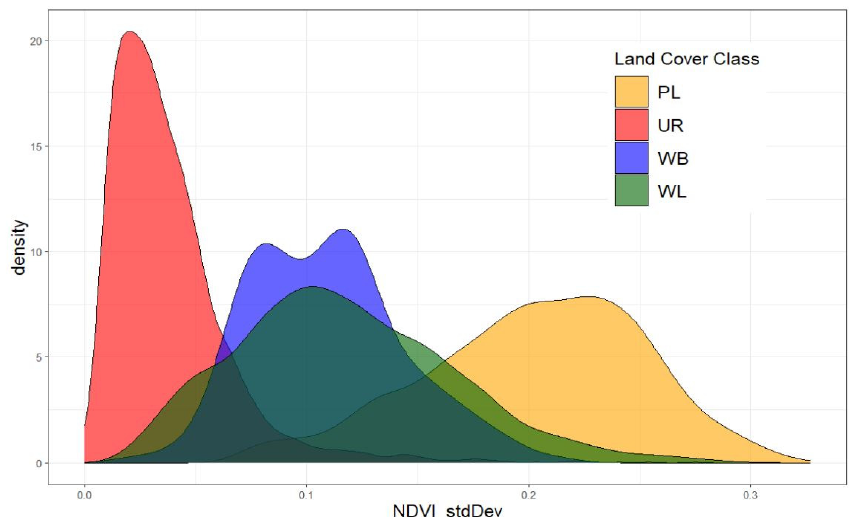
Figure 4. Density plot of the NDVI standard deviation parameter, the data referring to all sampling points in each sampling year. Table 8. Tukey HDS on NDVI standard deviation of all sampling pixels in each year. The table shows the difference ( Diff. ) between the mean values of the classes, lwr and upr show the lower and upper limits of the confidence intervals, respectively, and p -value shows the adjusted p -value for the tests. Values in bold show p -value < 0.05.